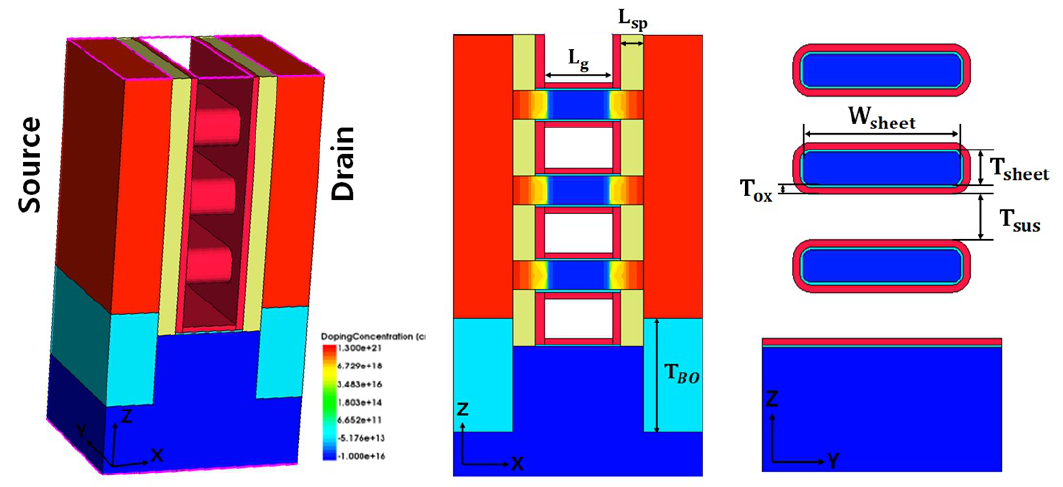
Figure 1. A schematic diagram of a 3D TCAD simulation of the